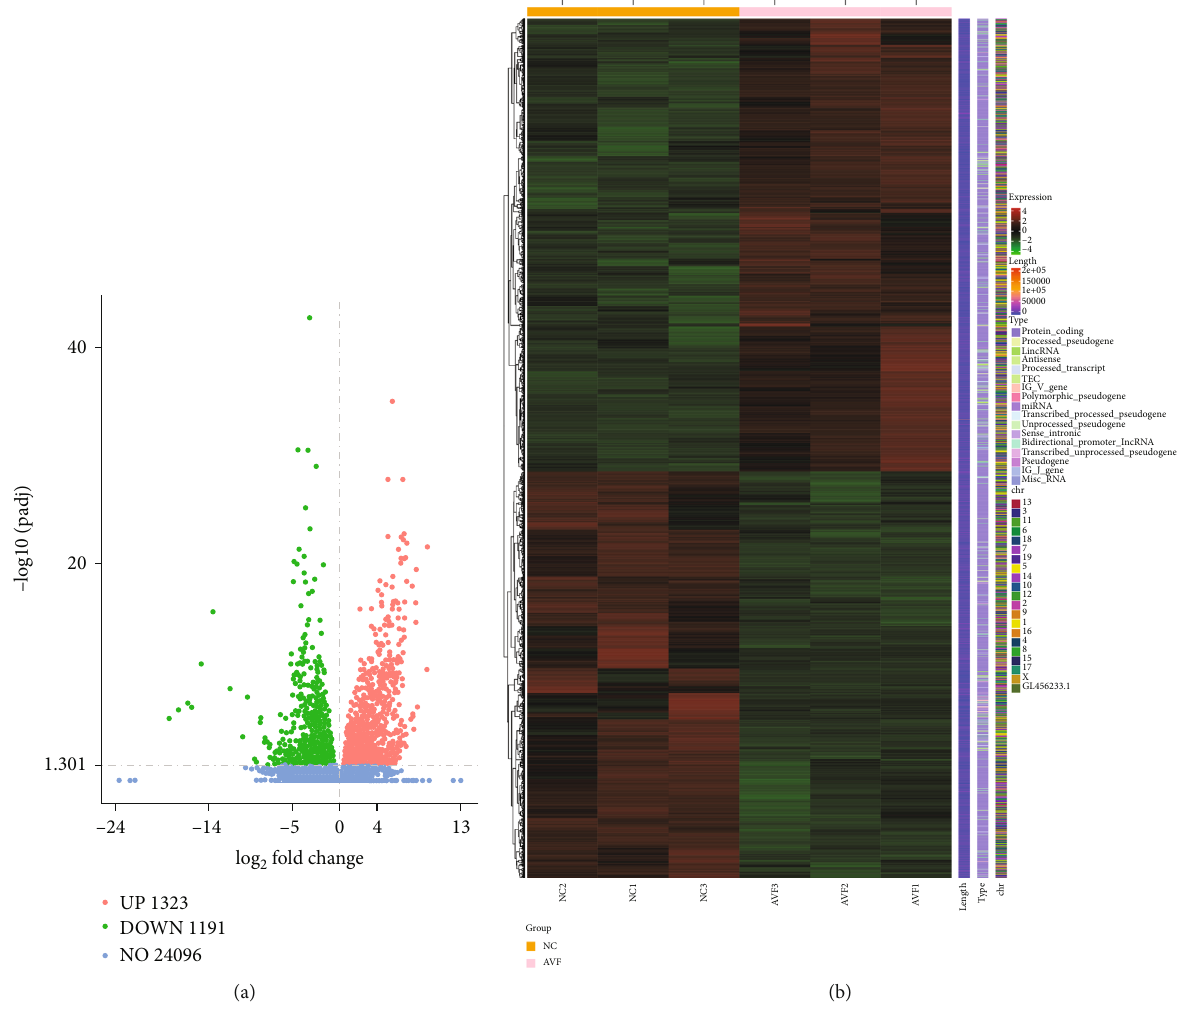
Figure 1: Screening of di ff erentially expressed mRNAs (DEmRNAs) between the normal control mice and the mice with arteriovenous fi stula (AVF). (a) The volcano plot of DEmRNAs. Red dots represent the upregulated genes, green dots represent the downregulated genes, and blue dots represent the genes with no signi fi cant di ff erence. (b) Bidirectional hierarchical clustering heat map of these